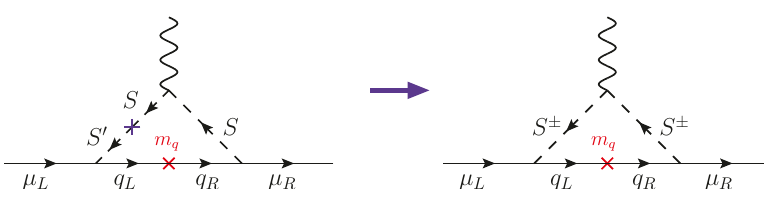
2) (cid:22) coming from the mixing of (cid:0)